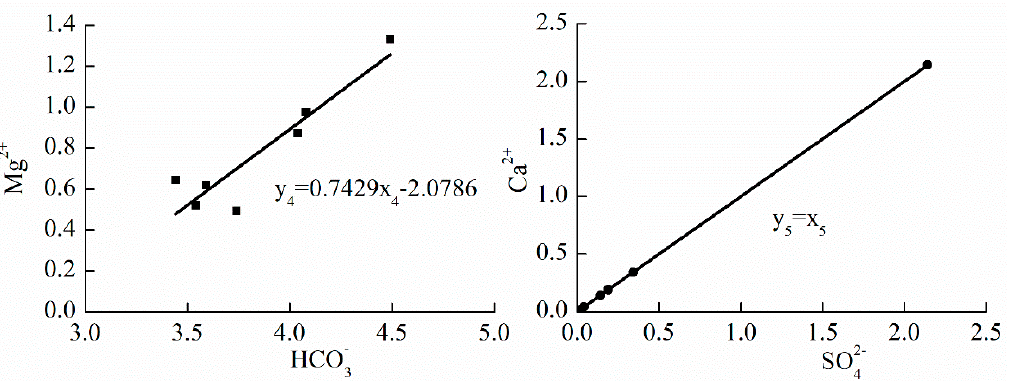
− and Mg 2+ vs. HCO